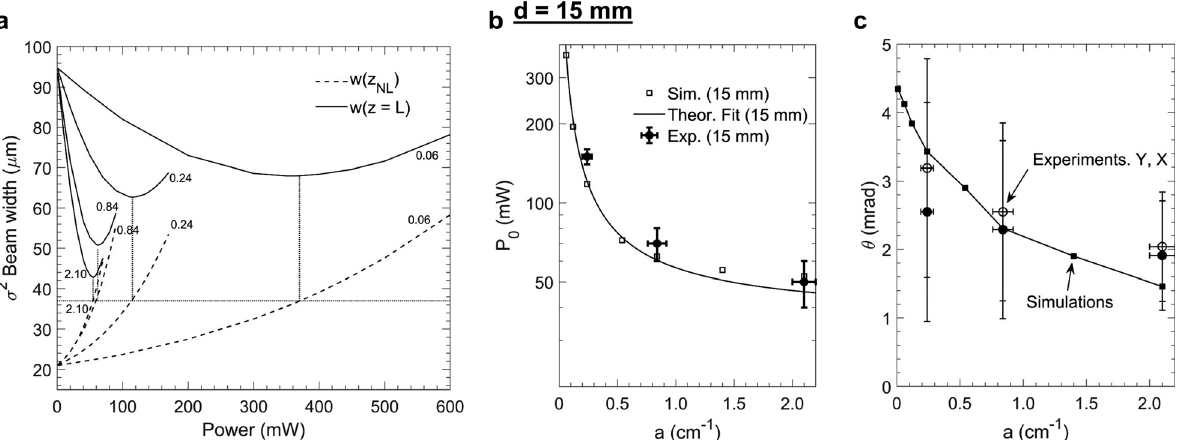
Figure 8: Results of numerical simulations based on the nonlinear Schrödinger equation with a thermal nonlinearity (Eqs. (A3) and (A4), Supplementary material)and comparison with experimental observations for d = 15 mm. (a) Numerical evaluation of the σ 2 beamwidth at the output w ( z = L ) (solidcurves)andofthe σ 2 nonlinearbeamwaist w ( z NL ) (dashedcurves)asafunctionof P .Thecalculationscorrespondtothe values of absorption coef fi cient a of the examined samples (in cm − 1 , shown close to each curve). Dotted lines indicate that at the in fl exion points of w ( z = L ) (i.e., at P = P 0 ) the nonlinear beam waist w ( z NL ) is stretched by the same factor m ∼ 1 . 75 compared to the linear beam waist w f = 21 μ m . (b) Comparison of P 0 (a) by numerical simulation (squares), fi tting of analytical expression (2) for m = 1.75 (solid line) and experimental values (circles). (c) Comparison of θ ( α ) between numerical simulations (squares) and experimental measurements